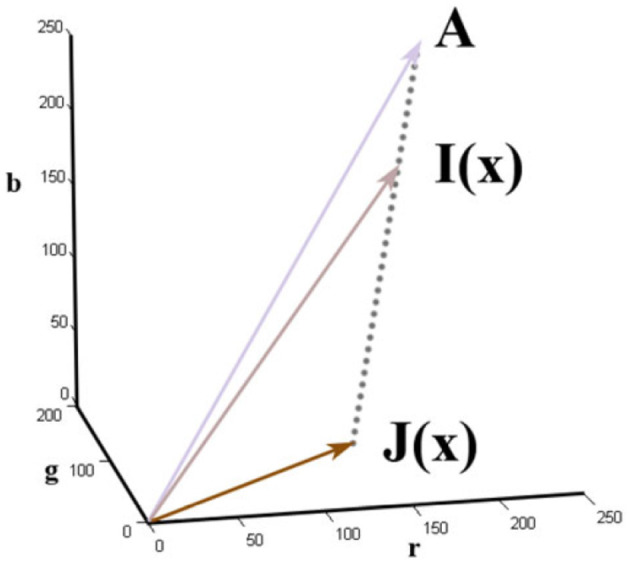
The image formation model used in dehazing, taken from He et al. (2011).